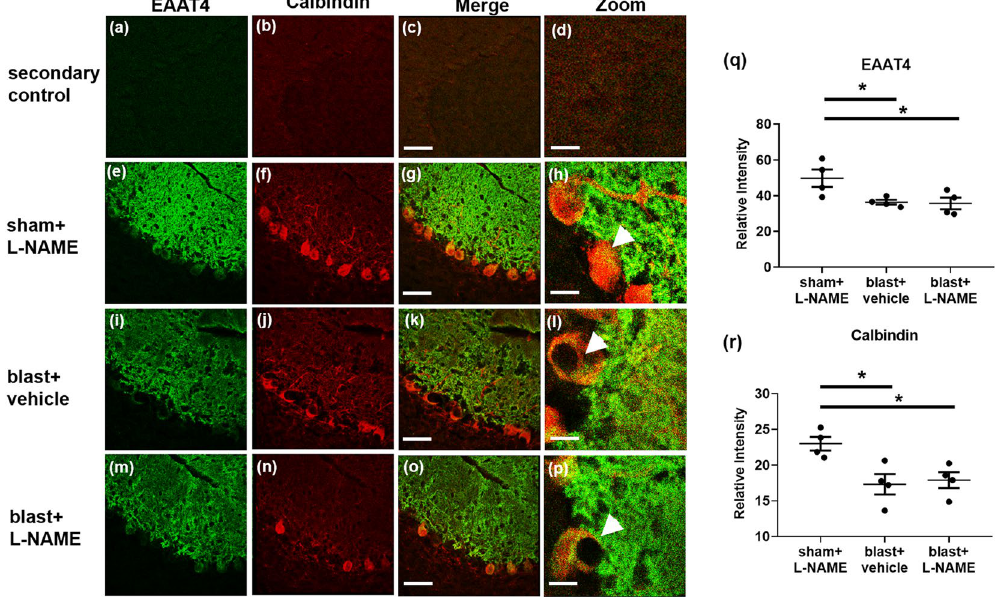
Figure 7. Reduced EAAT4 expression on cerebellar Purkinje cells was observed in mice exposed to repetitive blast injury. (a) Shows representative images of secondary only controls (no primary antibodies) for Alexa 488, (b) Alexa Cy3, (c) merged, and (d) zoomed (40 × ). (e) Shows representative immunofluorescent images of EAAT4 (green), (f) calbindin (red), (g) merged, and (h) zoomed images in lobule IX of the cerebellum in control mice at one month after 3X sham and L-NAME administration. (i) Shows representative images of EAAT4, (j) calbindin, (k) merged, and (l) zoomed images at one month after repetitive mTBI. (m) Shows representative images of EAAT4, ( n ) calbindin, (o) merged, and (p) zoomed images at one month after repetitive mTBI with L-NAME. A significant decrease in (q) EAAT4 ( * p ≤ 0.05), and (r) calbindin ( * p ≤ 0.05) immunofluorescence was observed in lobule IX of the cerebellum of mice exposed to both repetitive mTBI plus vehicle ( * p ≤ 0.05), and repetitive mTBI plus L-NAME ( * p ≤ 0.05). One-way ANOVA post hoc Newman- Keuls. Values represent means ± SEM. Arrowheads highlight EAAT4 + /calbindin + Purkinje cell bodies. Scale bars = 30 µ m, 20 µ m